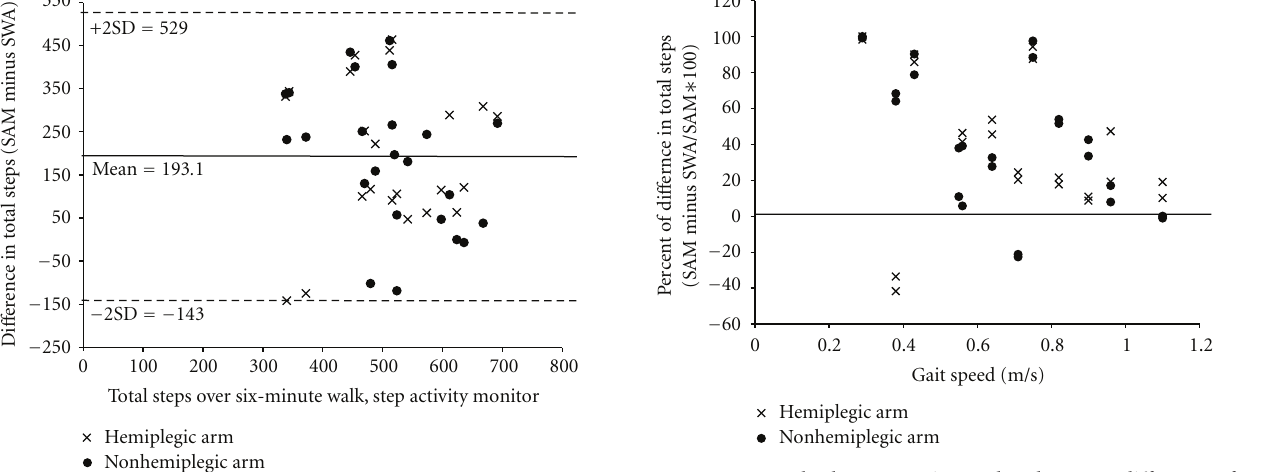
Figure 4: Scatterplot between gait speed and percent di ff erence of step count as measured by the Step Activity Monitor (SAM) and the SenseWear Armband (SWA). Percent di ff erences less than zero indicate overestimation by the SWA. Each participant has four data points (one for each arm for each 6-minute walk test), viewed in a vertical line from the gait speed value. Note: there are only two data points for the participant for whom the SWA malfunctioned on the hemiplegic